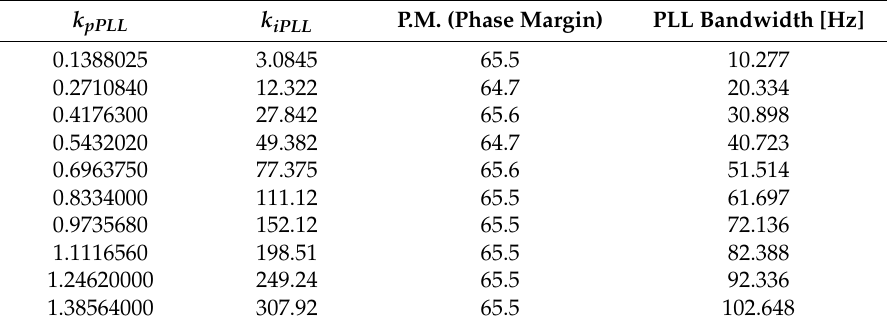
Table 2. PLL designs.